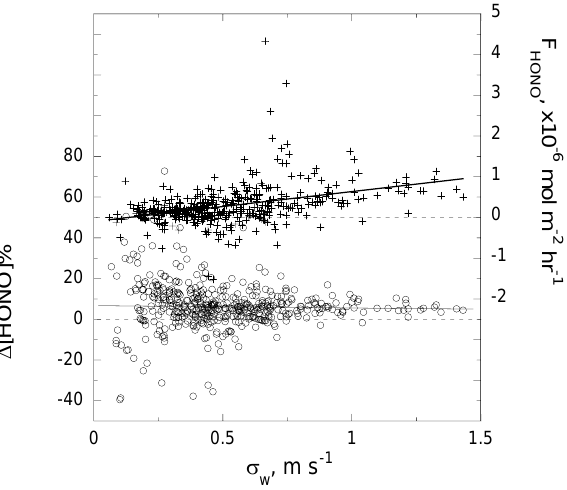
Fig. 6. The percentage difference between HONO concentrations (open circles, left axis) in the updraft and downdraft air masses and HONO flux (crosses, right axis) as functions of standard deviation of vertical wind